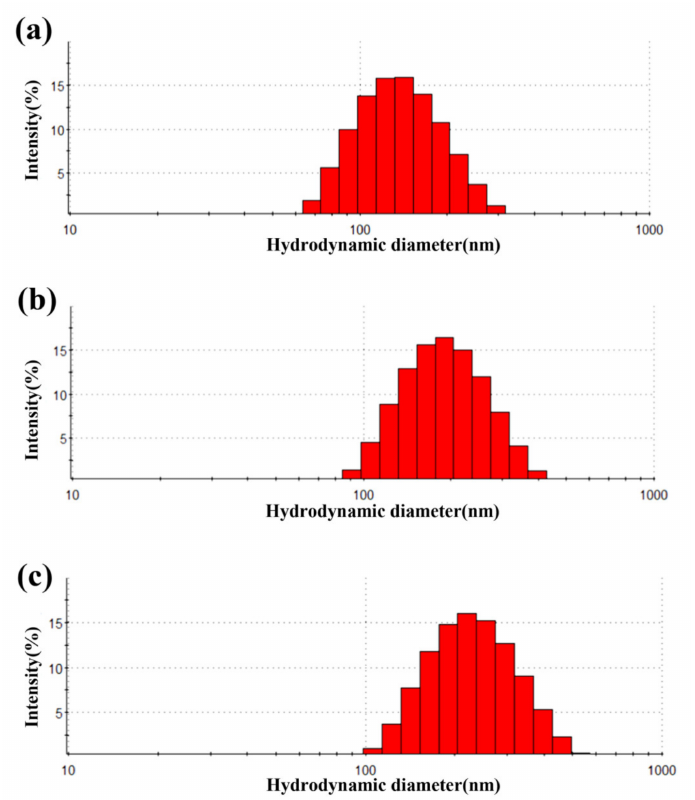
Figure 4. Variation of hydrodynamic diameter. ( a ) Hydrodynamic diameter of Fe 3 O 4 , ( b ) Fe 3 O 4 @